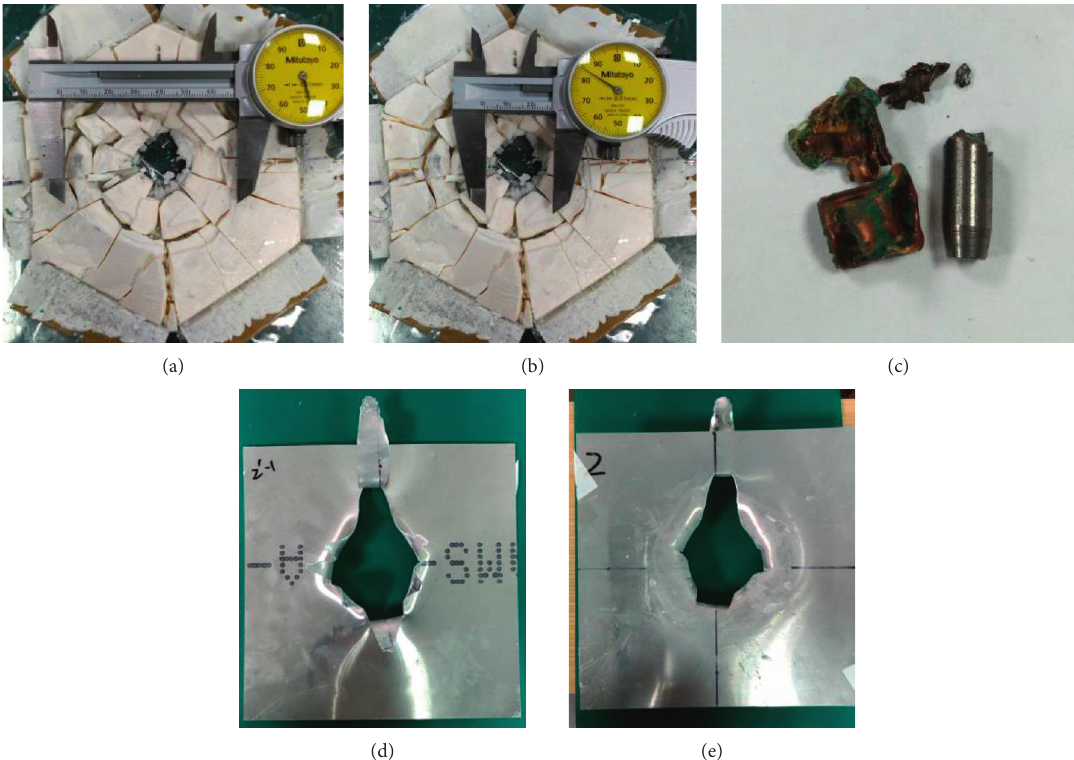
Figure 11: 5%333 FGM+1 mm Al backplate. (a) The bottom of the ceramic conoid. (b) The top of the ceramic conoid. (c) Residual bullet. (d) The back of the aluminum backplate. (e) The front of the aluminum